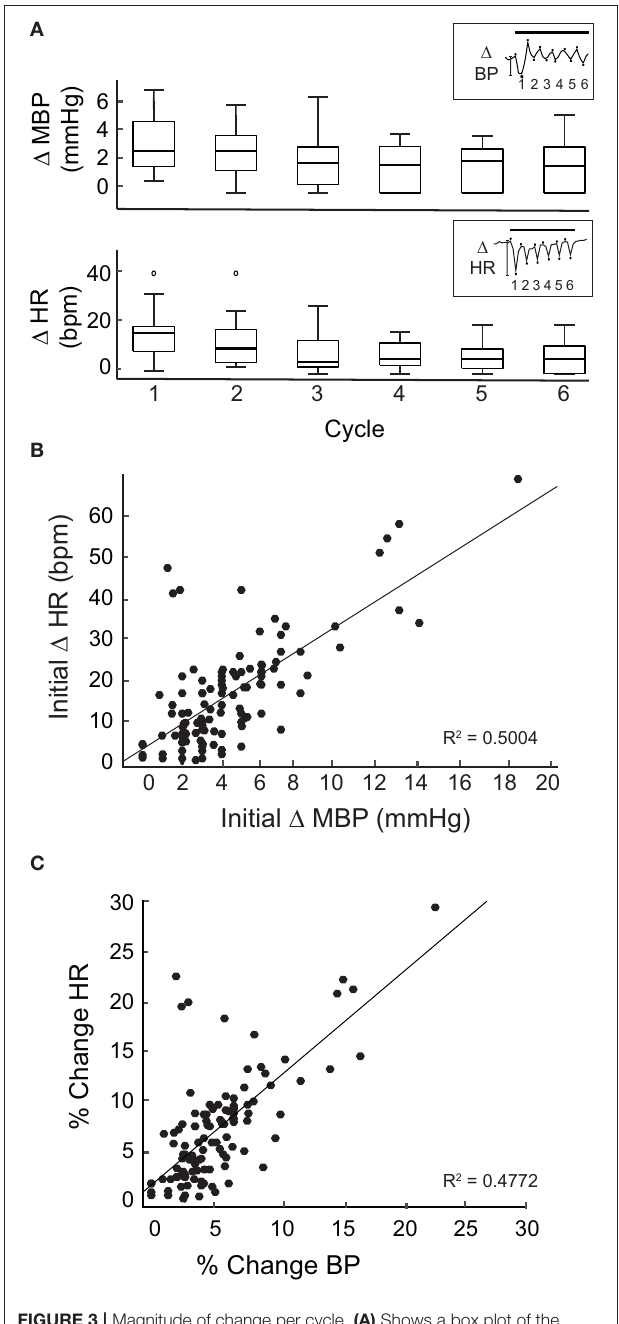
FIGURE 3 | Magnitude of change per cycle. (A) Shows a box plot of the changes in MBP (top) and HR (bottom) for each cycle (20s) of the 2-min stimulation period at 470 µ J/pulse in 6 rats. Inset shows one example of a MBP (top) and HR (bottom) measurement during a stimulation event at 470 µ J/pulse divided into 6 cycles. The magnitude of change was measured peak-to-peak (*) for each cycle. Change in MPB and HR between cycles was not significant [repeated measures ANOVA: HR ( p = 0.3644) and BP: ( p = 0.7952)]. (B) The initial change in MPB (mmHg) from 113 events in 17 rats correlated moderately to the corresponding initial changes in HR (bpm) ( R 2 = 0.5004, p < 0.0005). (C) Percent change was taken for both MBP (initial change MBP/MBP baseline) and HR (initial change HR/baseline HR) at 113 stimulation events across 17 rats. The percent changes in HR and MBP correlated moderately ( R 2 = 0.4772, p <